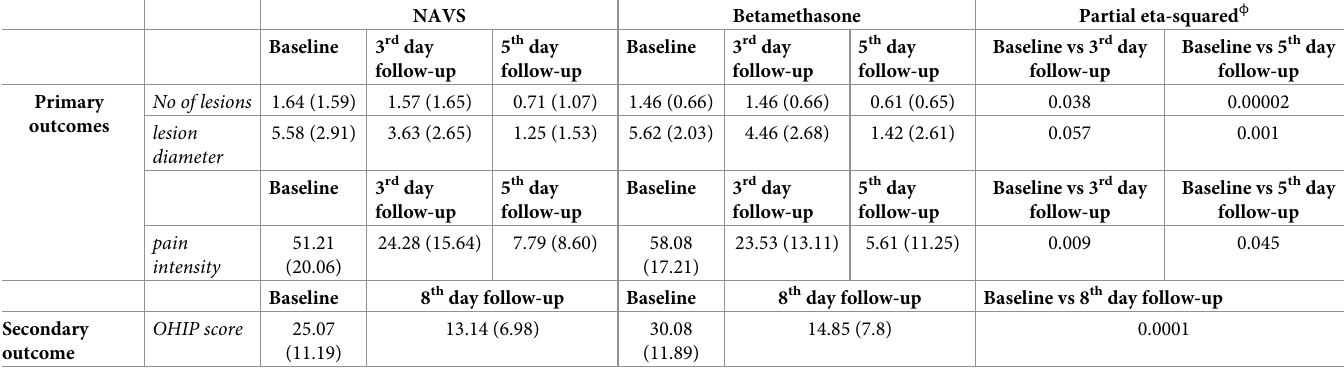
Table 6. Means and SDs of outcome measures for each group at each time point (RAS patients).